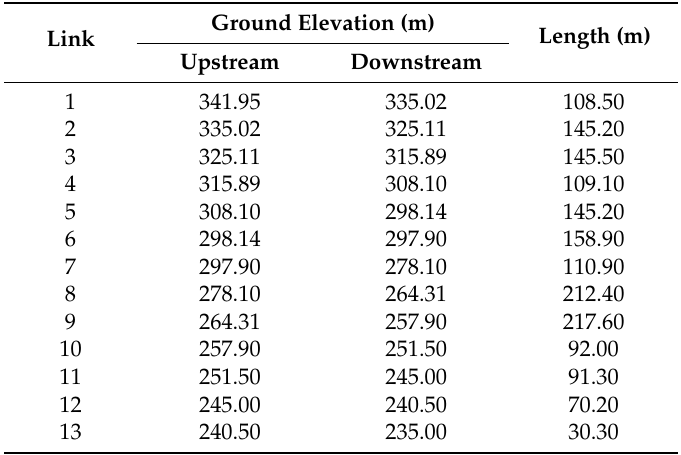
Table 2. Summary of basic storm sewer information in case 2.